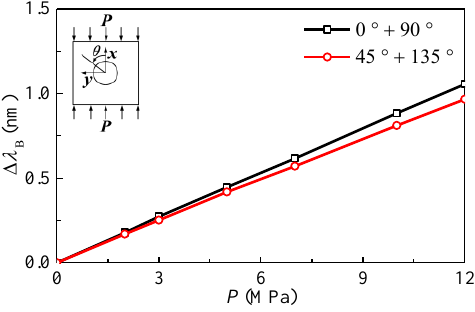
Figure 12. Variation of wavelength shifts of FBGs spaced 90° apart with applied loads. Table 1. Comparison between applied load and calculated stress.